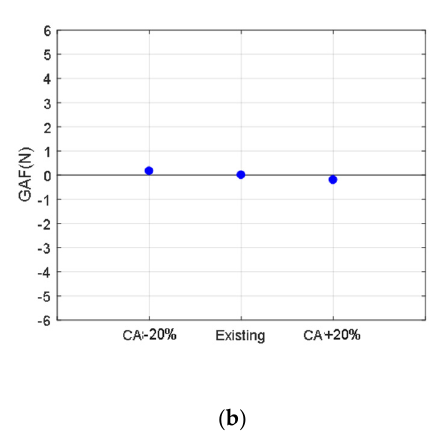
Figure 12. GAF changes with respect to ( a ) track curvature ( b ) contact angle.